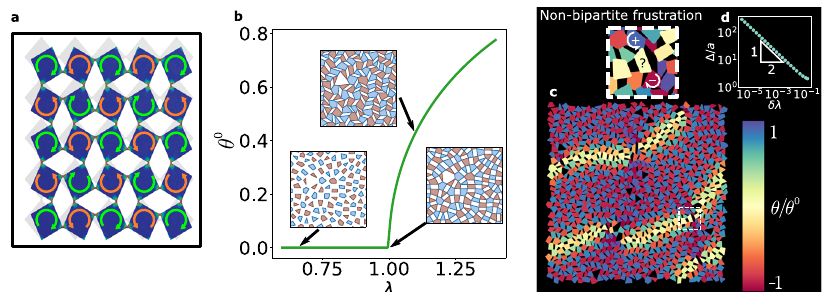
Fig. 4 Antiferromagnet spin analogy. a Finite element simulation of a square units auxetic. The auxetic basic mechanism lies in the coordination and synchronisation of the buckling instability at each of the weak links that provide the structure its stability. The effective collective pattern that emerges is analogue to an antiferromagnetic arrangement. Each of the two interconnected lattices that fi t the bipartite system rotate in opposite directions, as indicated by the green and orange arrows. b The rotation angle θ 0 as a function of the compression λ , for C = 1. Analogous to an antiferromagnetic system, the material goes through a phase transition from a stretched state, to a compressed rotated state. With its critical point located at at λ = 1. c By breaking the bipartivity the auxetic will frustrate, creating local defects that don't rotate as predicted. Here we showcase a non-bipartite random polygon network, when compressed a system spanning defect appears (yellow), reminiscent of a domain wall. The colour represents the rotation of each polygon, red being clockwise and blue counter clock wise, yellow shows the frustrated polygons. To create this defect, periodic boundary conditions where applied to an initially bipartite network, this boundary condition created a non-local odd cycle which destroyed the bipartivity. d The domain wall length Δ , normalised by the polygon size a , plotted against the isotropic expansion parameter δλ , it ’ s evident that Δ ~ δλ − 1/2 , more on Supplementary Note